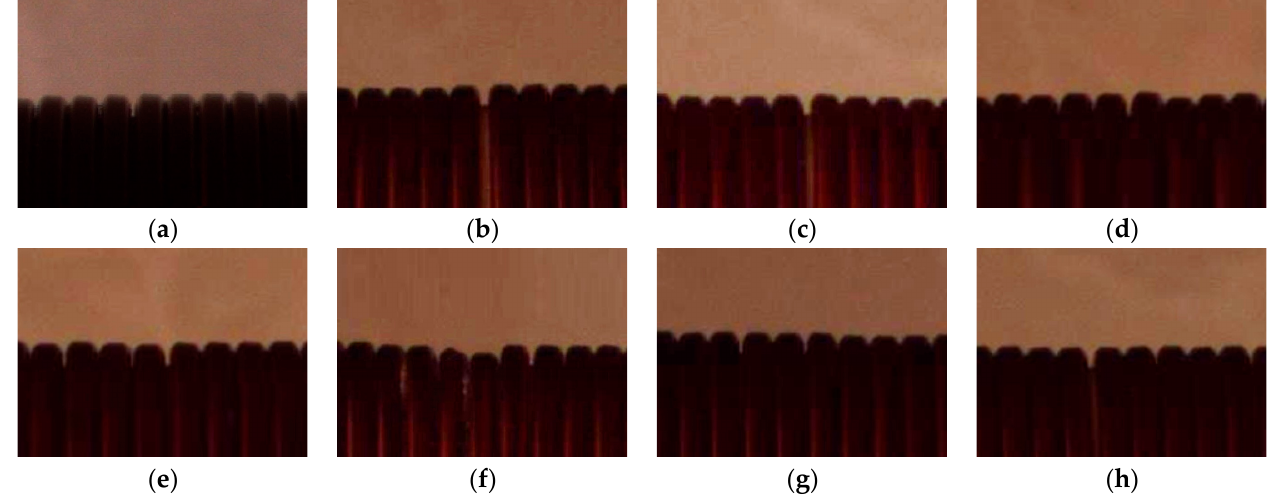
Figure 23. ROI image of the guide wire profile: ( a – d ) is the ROI of the 2.4 mm wire profile; ( e – h ) is the ROI of the 2.6 mm wire profile.